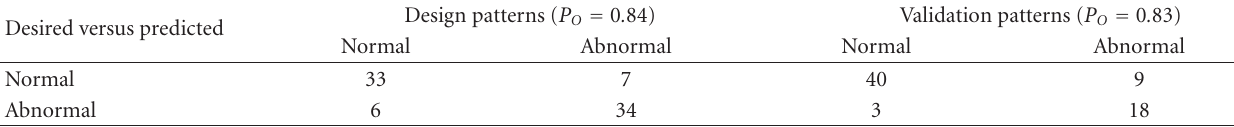
Table 2: FLND confusion matrices for patterns X D ( N D = 80) and X V ( N V = 70). Design patterns ( P O = 0 . Desired versus predicted